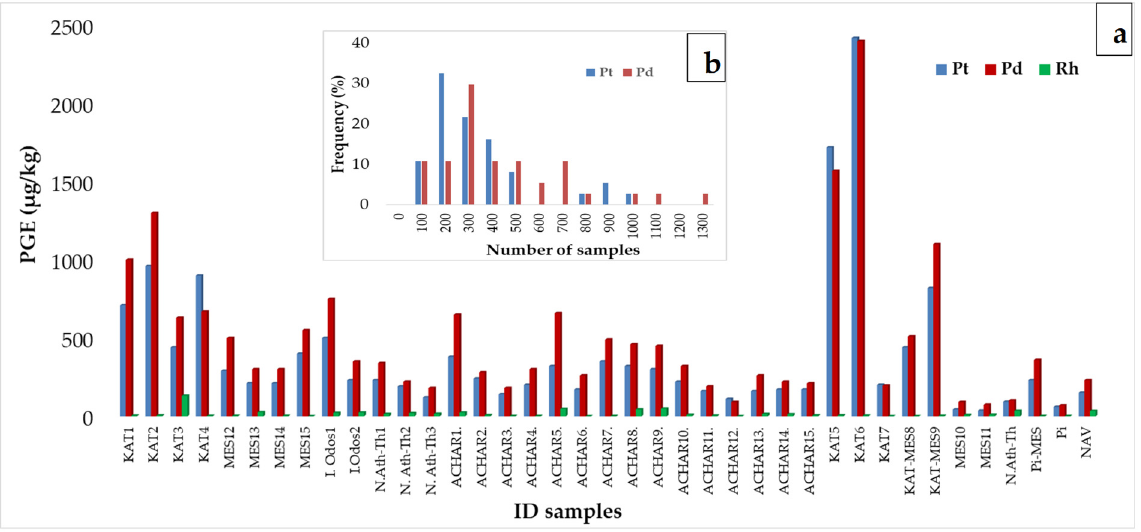
Figure 3. Variation in the Pt, Pd, and Rh contents (in μ g/kg), in dust and soil samples along the roadsides of highways of Attica ( a ); total frequency (%) versus number ( b ), without the two samples from gully pots. Data from Table 1.